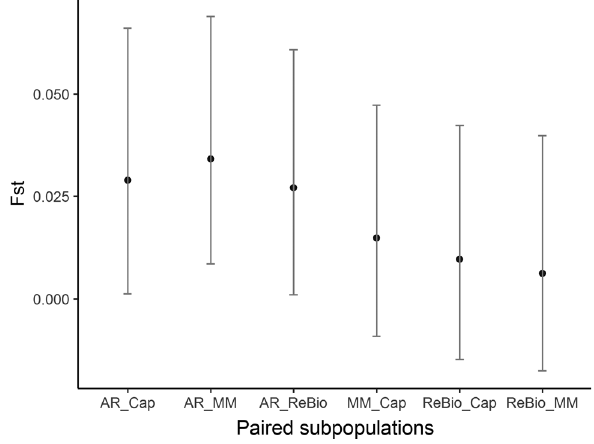
Figure 5 - F ST estimated values with nSSR markers and 95% confidence intervals based on 10.000 bootstrap values of E. ovata sampled in four subpopulations.